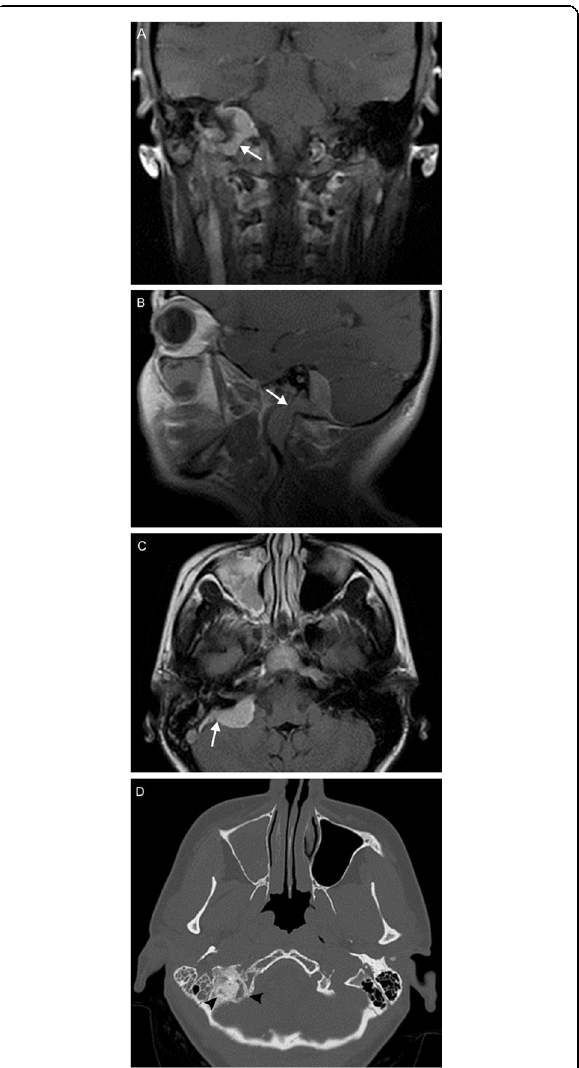
Fig. 15 Meningioma. A 45-year-old woman initially presenting with right sensorineural loss, followed by headache, dysphagia, dysphonia, imbalance, and vasovagal syncope. Coronal ( a ), sagittal ( b ), and axial ( c ) post-contrast T1-weighted MR images reveal a dural-based mass at the right cerebellopontine angle (white arrows) extending into the internal auditory canal, as well as through the jugular foramen into the carotid space. Axial contrast-enhanced CT ( d ) reveals diffuse hyperostosis of the right temporal bone with opacification of the mastoid air cells (black arrowheads). Overall, findings are consistent with a meningioma. Incidental severe right maxillary sinus mucosal thickening is also